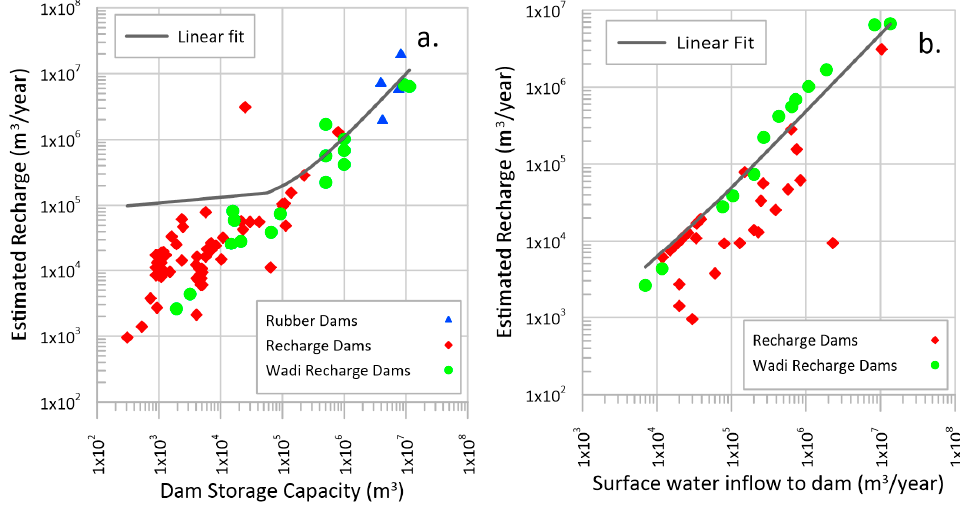
Figure 4. ( a ) Dam storage capacity (m 3 ) vs. estimated annual recharge (m 3 ). ( b ) Estimated annual runoff vs. estimated groundwater recharge for recharge dams and wadi-recharge dams (no equivalent data for rubber dams).